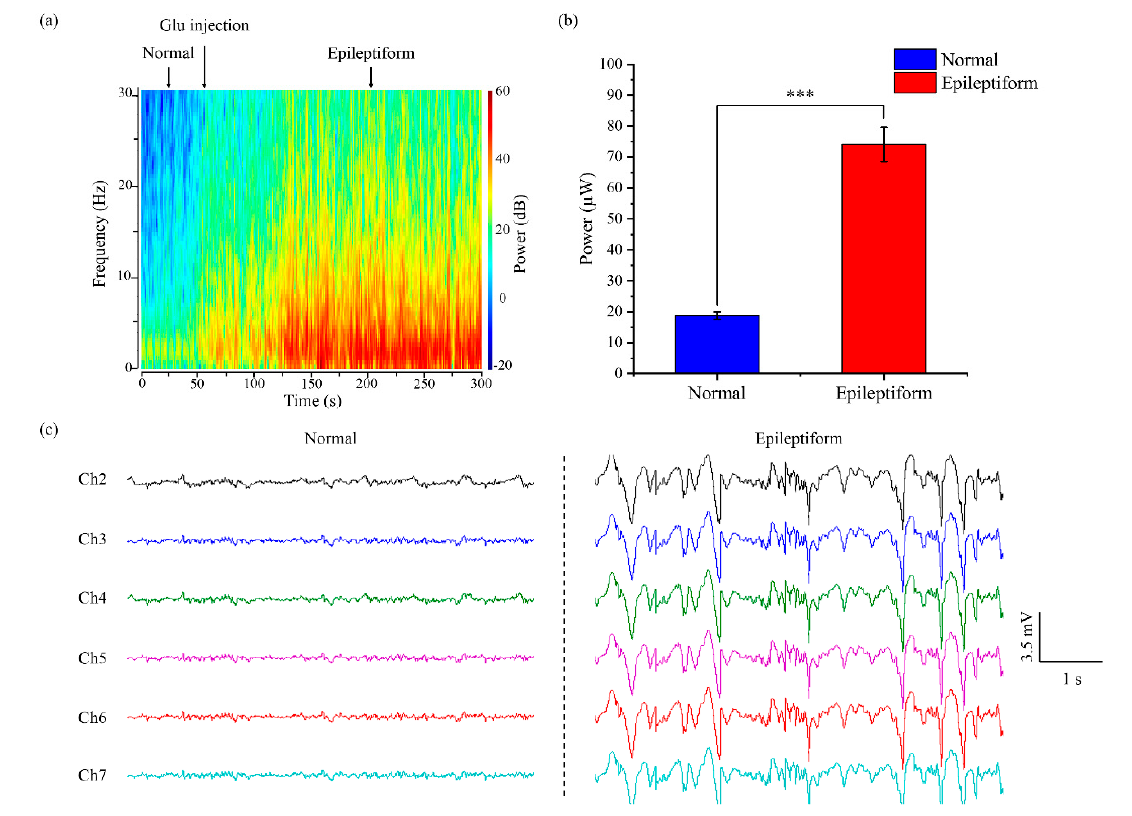
Figure 7. Epileptiform electrical activity recording using ECoG electrode array. ( a ) Time-frequency power spectrum; ( b ) Power analysis of normal and epileptiform activity. (*** P < 0.001). The data from six channels were calculated; ( c ) Simultaneous multisite recording with ECoG electrode array.